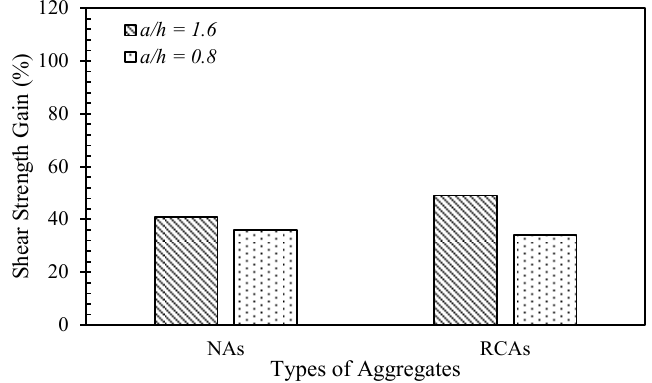
Figure 20. Shear strength gain of the models with minimum stirrups at different a/h ratios.